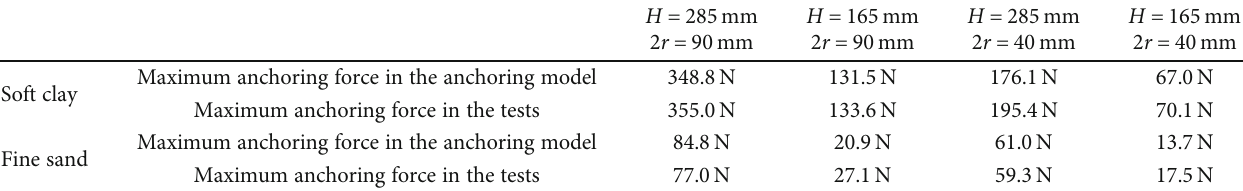
Table 2: Comparison of anchoring model with experiments in soft clay and